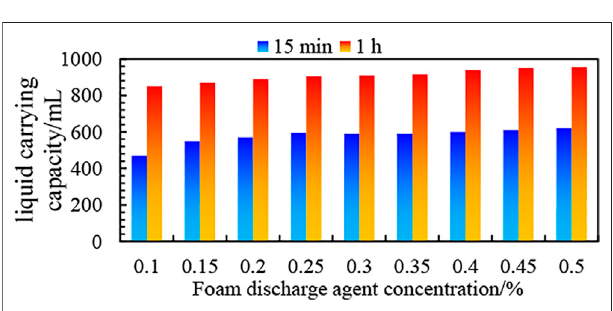
FIGURE 4 | Liquid-carrying capacity of ZHY-01 at different concentrations. FIGURE 5 | Liquid-carrying energy of AES at different